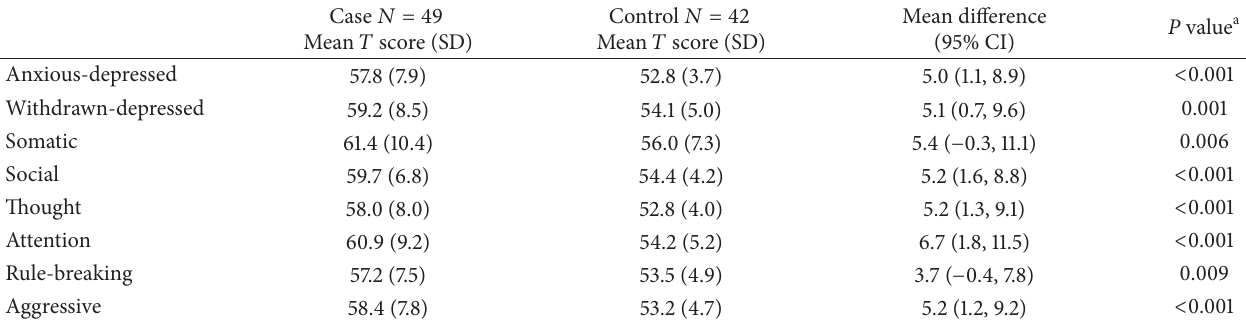
Table 5: Mean 𝑇 scores and mean differences for syndrome scales for cases and controls.